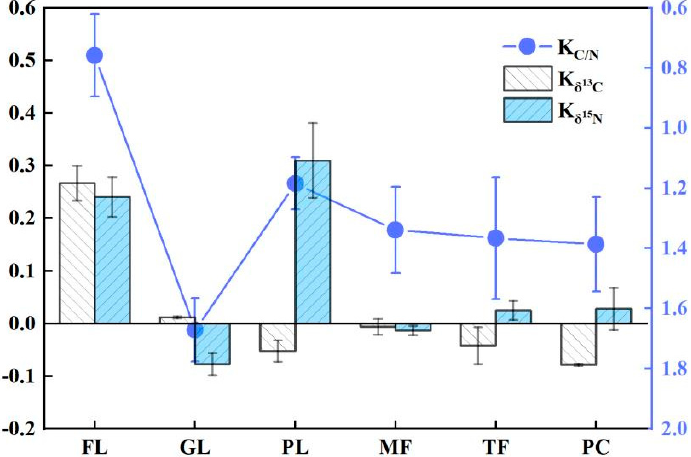
Figure 3 . Rates of change of soil δ 13 C, δ 15 N and C/N for six land use types from the rainy season to the dry season. K C/N ， K δ 13 C ， K δ 15 N are the rates of change of the soil C/N, δ 13 C and δ 15 N, respectively.